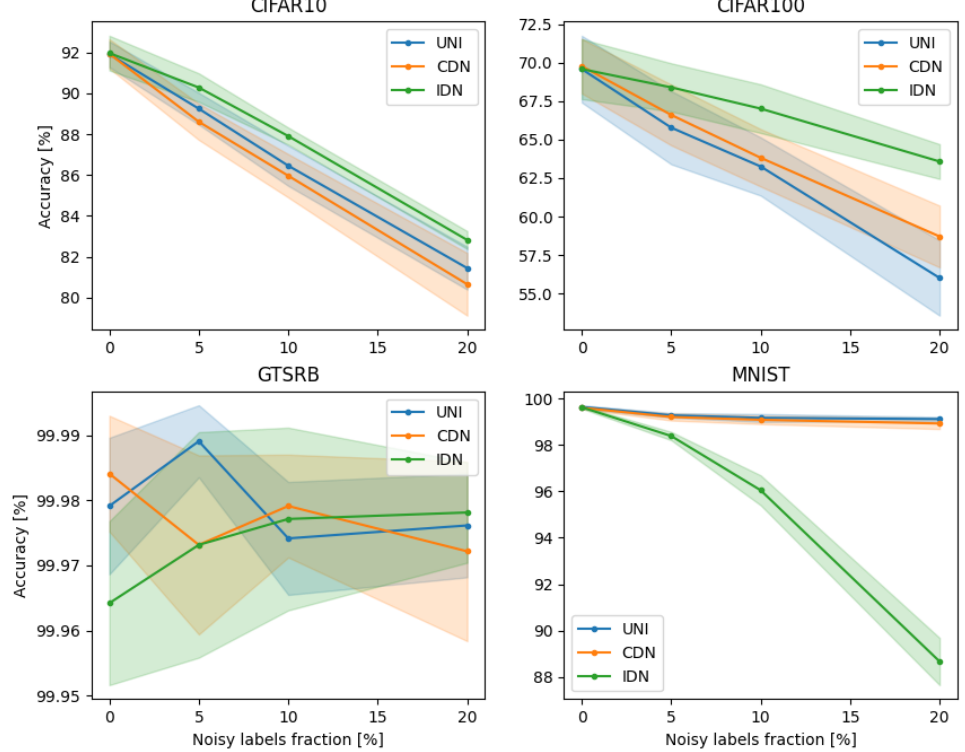
Figure 6. Dependence of DNN classification accuracy on label noise type and